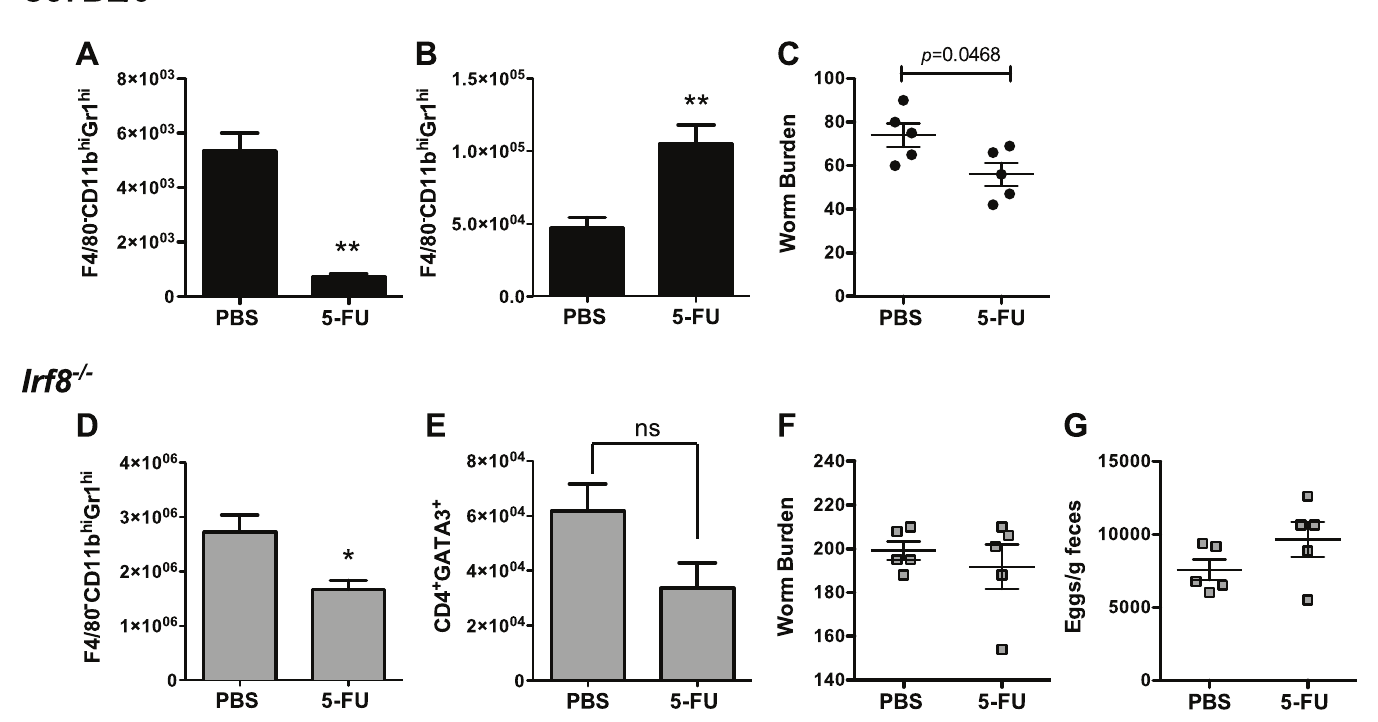
Fig 5. Effect of MDSC depletion on worm burdens in Hpb-infected C57BL/6 and Irf8 -/- mice. Numbers of F4/80 - CD11b hi Gr1 hi cells in MLN of infected C57BL/6(B6) mice treated with PBS or 5-FU on (A) day 7 or (B) day 14 p.i. (C) Adult worm burdenson day 14 p.i. of individualB6 mice treated with PBS or 5-FU. Numbers of (D) F4/80 - CD11b hi Gr1 hi and (E) CD4 + GATA3 + T cells in MLN of infected Irf8 -/- mice treated with PBS or 5-FU on day 14 p.i. (F) Adult worm burdenson day 14 p.i. and (G) fecal egg counts on day 13 p.i. of individual infected Irf8 -/- mice treated with PBS or 5-FU. Data are representative of two replicateexperiments each with n = 5 mice per group. Data are presentedas mean ± SEM. ns, not significant; * , p (cid:20) 0.05; ** , p (cid:20) 0.01.